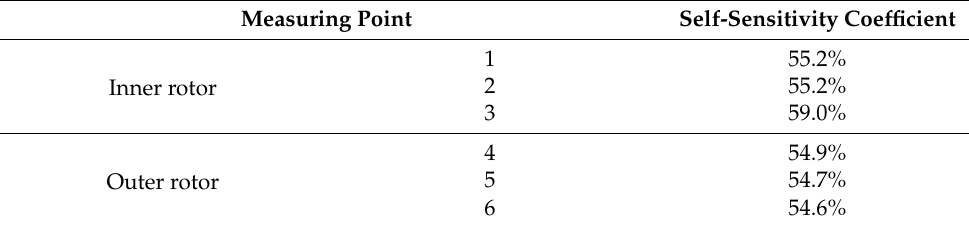
Table 2. Response of each measuring